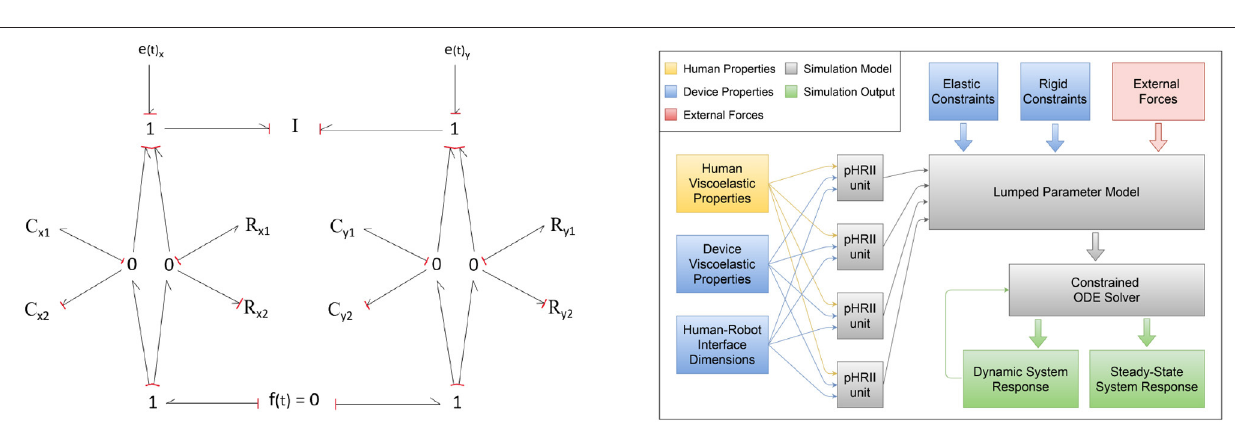
FIGURE 4 | (Left) Bond graph of a single PHRII unit. The left half represents features in the tangential or x -direction while the right represents normal or the y -direction. (Right) Block diagram showing information flow across the different elements of the simulation